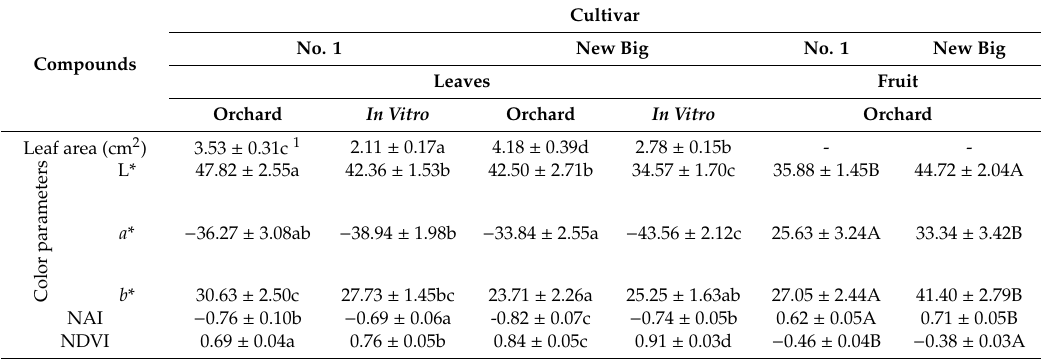
Table 3. The leaf area, color measurement and NAI and NDVI value in leaves and fruit of two cultivars of goji cultivated in orchard and in vitro